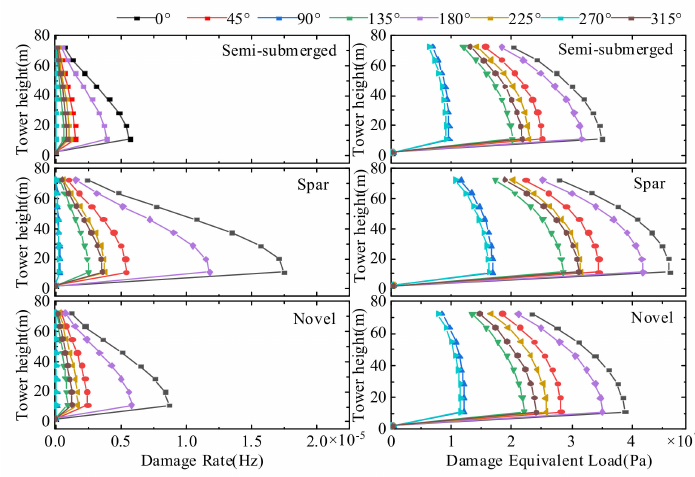
Figure 33. Damage Equivalent Load and Damage Rate of three FOWT towers.